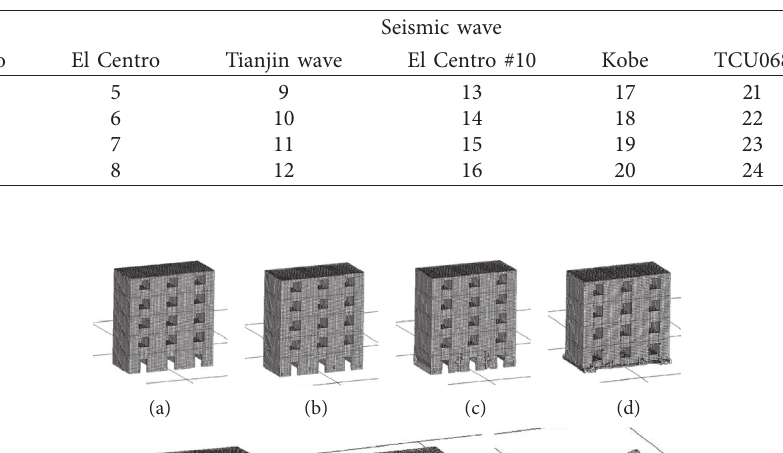
Figure 5: Comparison of seismic response spectrum mean and normative response spectrum. Table 3: 28 working conditions.